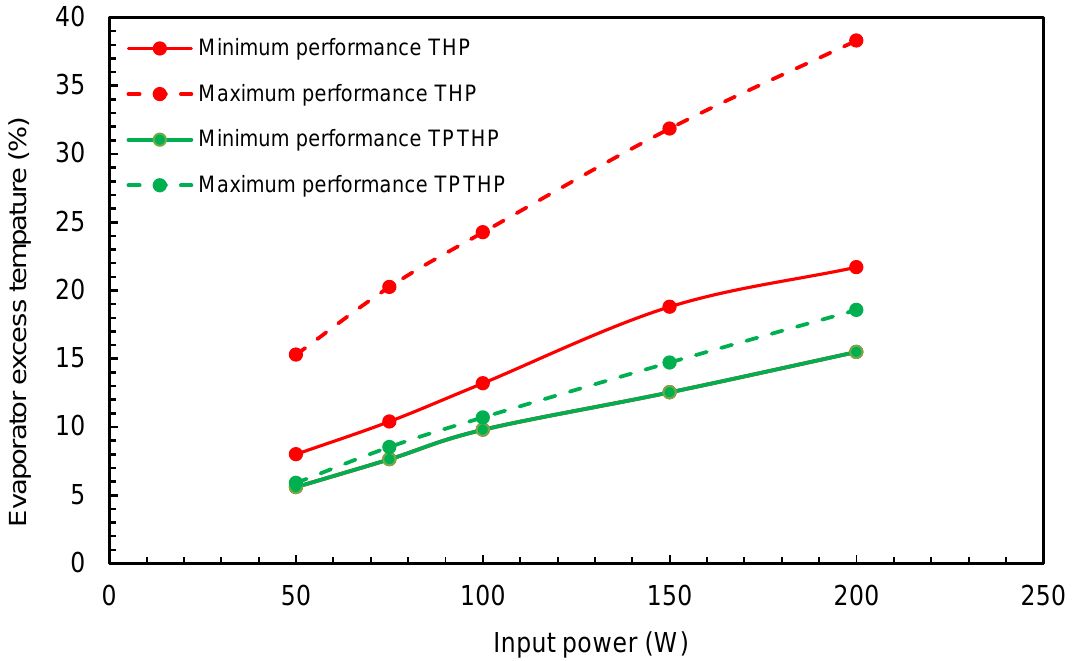
Figure 17. The evaporator excess temperature for the optimum dimensions of TPTHP and THP.